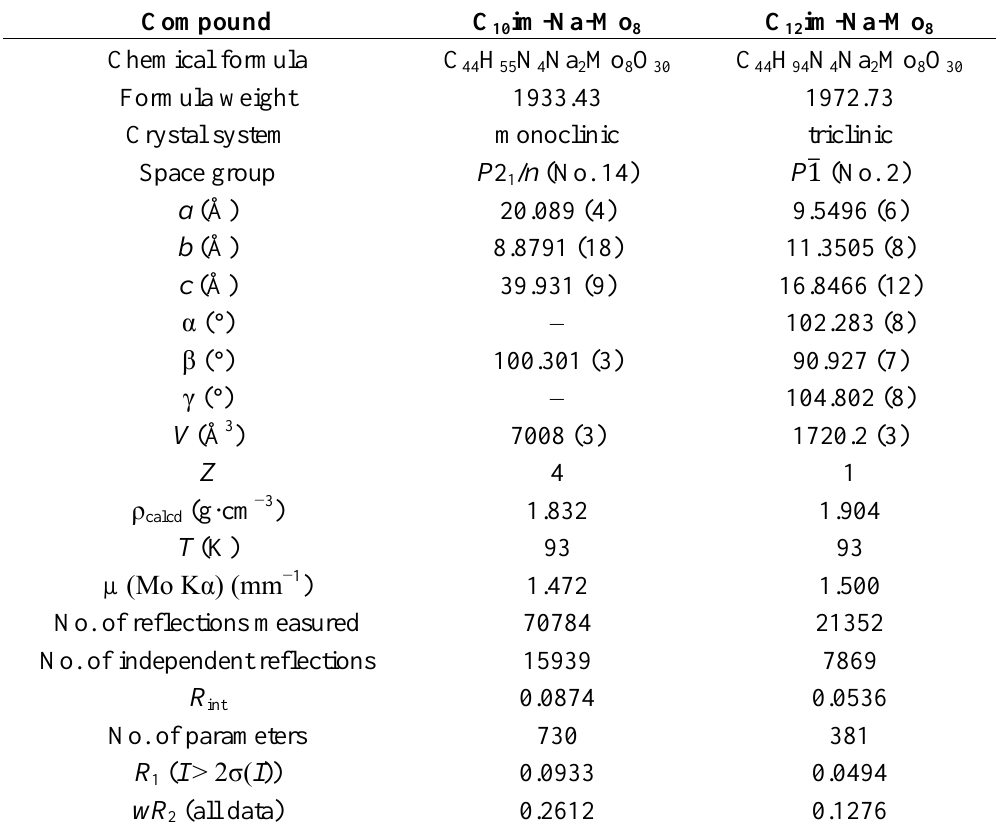
Table 1. Crystallographic